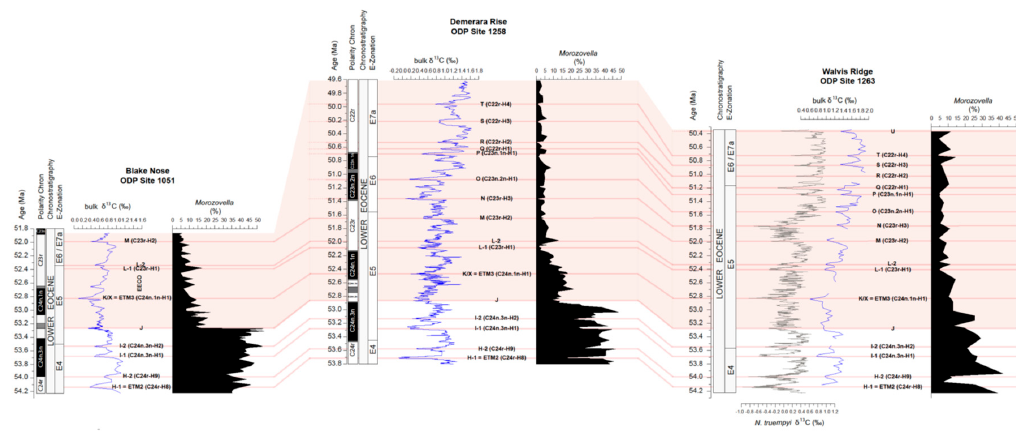
Figure 6. Early Eocene δ 13 C and relative abundance of genus Morozovella plotted versus Age (Ma) from Atlantic sites 1051, 1258 and 1263. Note that the permanent decline in abundance